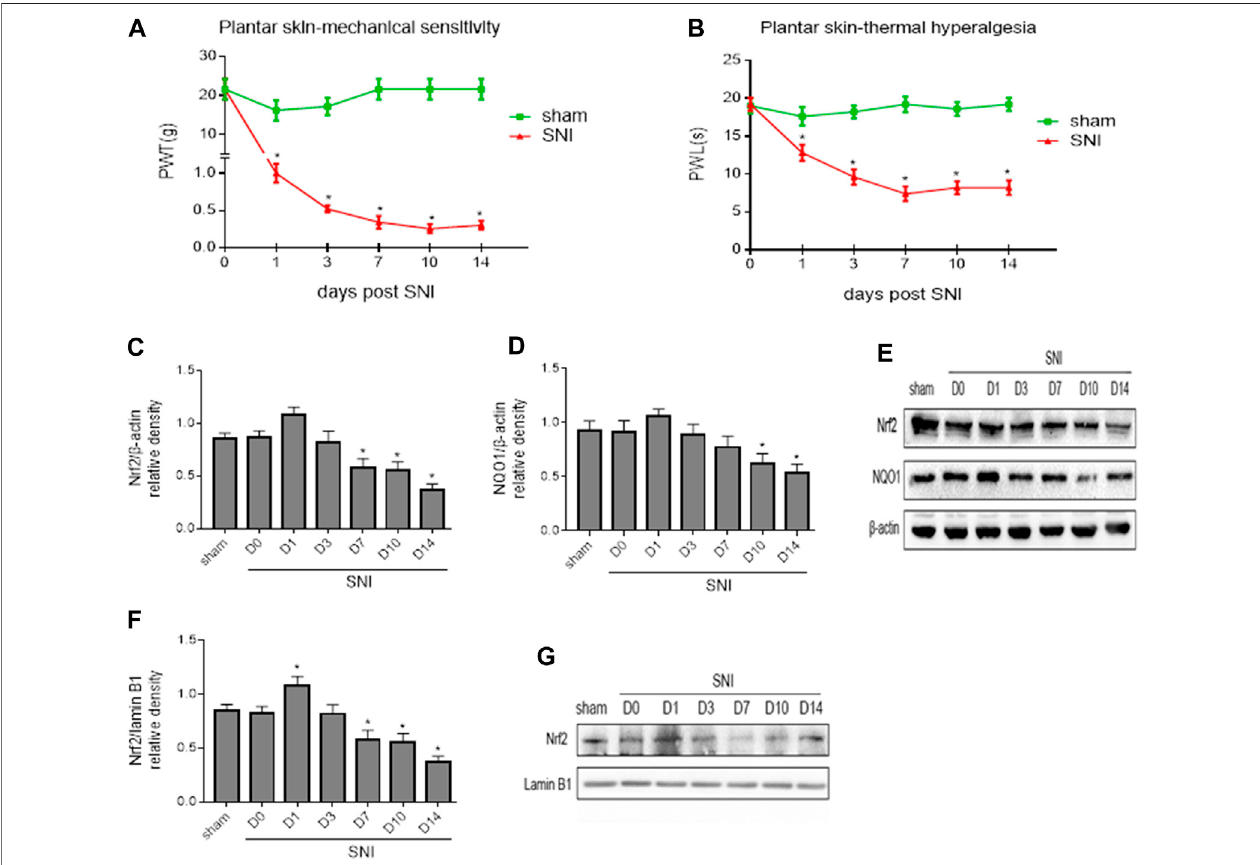
FIGURE 2 | (A,B) : Paw withdrawal threshold (PWT) to mechanical stimulation and paw withdrawal latency (PWL) to thermal stimulation before (day 0) and 1, 3, 7, 10and14days afterspared nerveinjury(SNI)orshamoperation. (C – E) :Thetime courseofchangesinexpression ofNrf2and itsdownstream targetNQO1 inthewhole tissuelysatesofthespinalcordinSNIrats. (F,G) :ThetimecourseofchangesinexpressionofNrf2inthenuclearfractionsofthespinalcordinSNIrats.Shamratsserved as control. Values are expressed as mean ± SE (n (cid:1) 5 for each group). * p < 0.05 vs sham or baseline (day